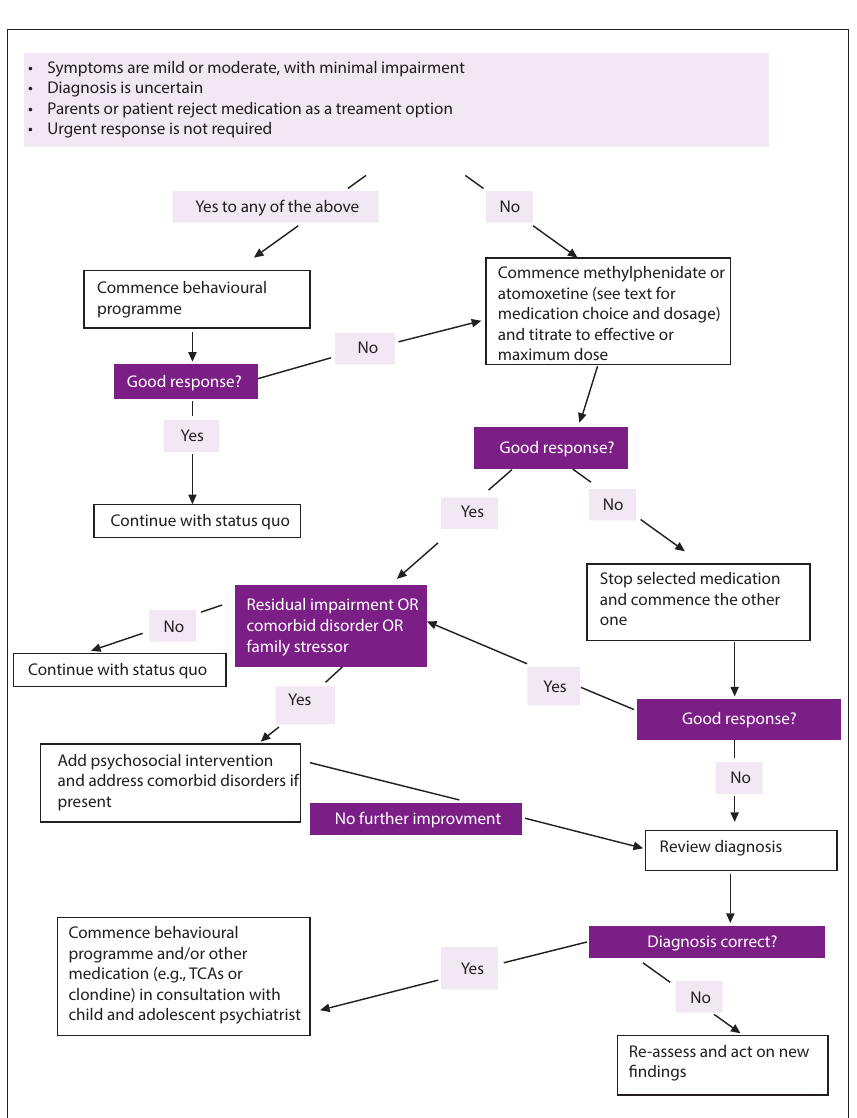
Fig. 1. Treatment algorithm (TCAs – tricyclic